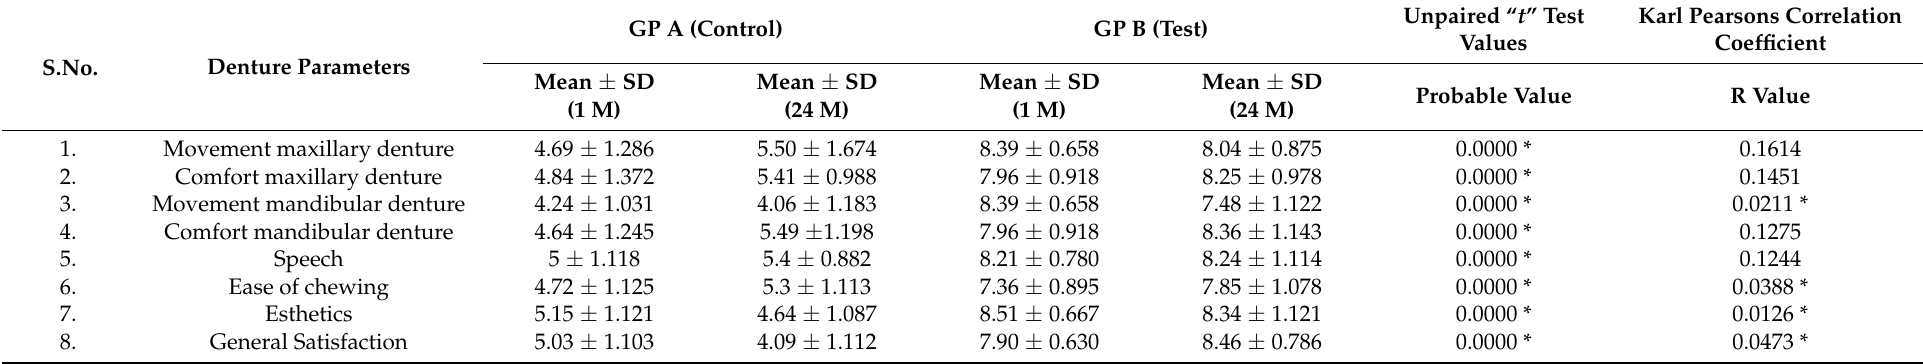
Table 3. Comparative differences in means among various parameters for denture satisfaction at two different intervals of time between the studied groups.